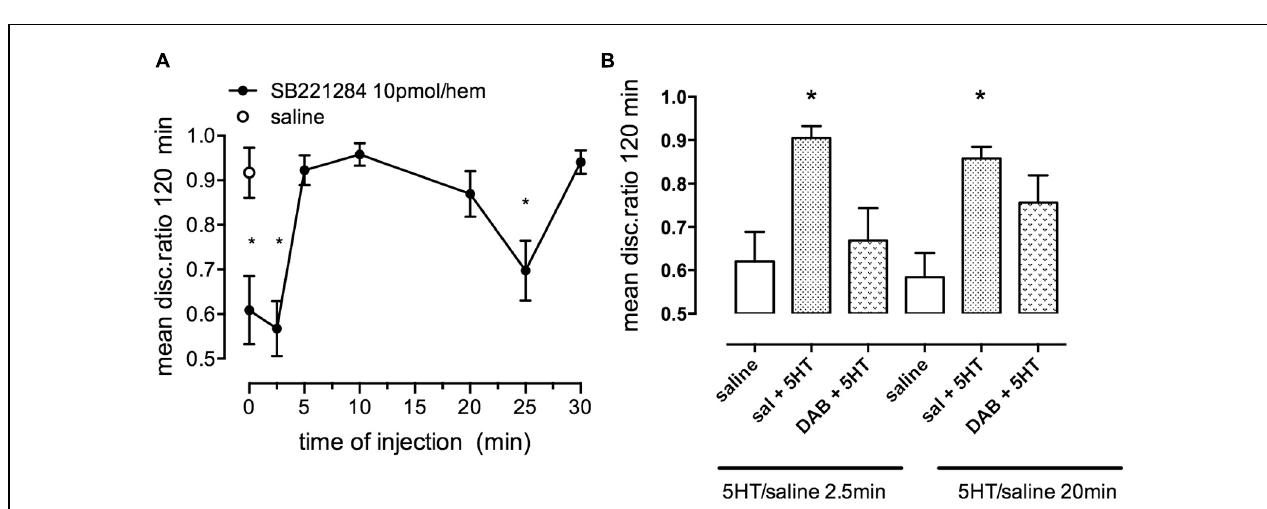
FIGURE 9 | Effect of the selective 5-HT 2B / C receptor antagonist SB221284 on strongly reinforced memory. (A) Time of injection of SB221284 following strongly reinforced training. (B) Ability of the inhibitor DAB to prevent consolidation of weakly reinforced memory. A suboptimal dose of DAB was given either before or 15 min after training, serotonin was given 2.5 or 20 min after training. DAB only interfered with serotonin induced consolidation at the early period. * P < 0.05. (From Gibbs and Hertz,